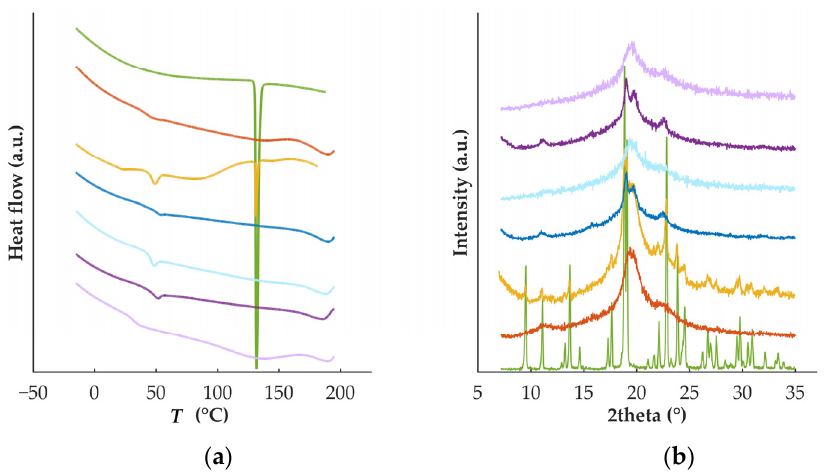
Figure 1. ( a ) Thermograms and ( b ) diffractograms of DZP (green) and PVA (orange) raw materials, physical mixture (yellow) and placebo filaments (dark blue) or tablets (light blue), and DZP-loaded filaments (dark purple) or tablets (light purple).